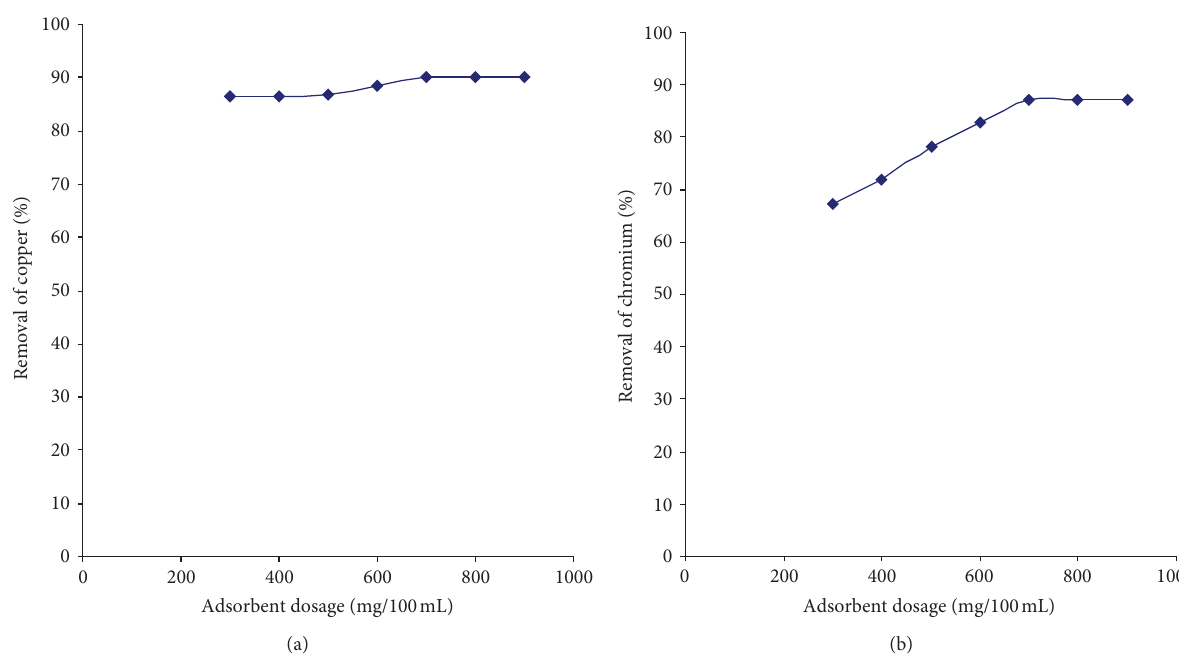
F 3: (a) e effect of variation of adsorbent dosage on copper adsorption by henna leaves an initial concentration of 100ppm, 90min, and pH 7. (b) e effect of variation of adsorbent dosage on chromium adsorption by henna leaves an initial concentration of 100ppm, 90min, and pH 7.